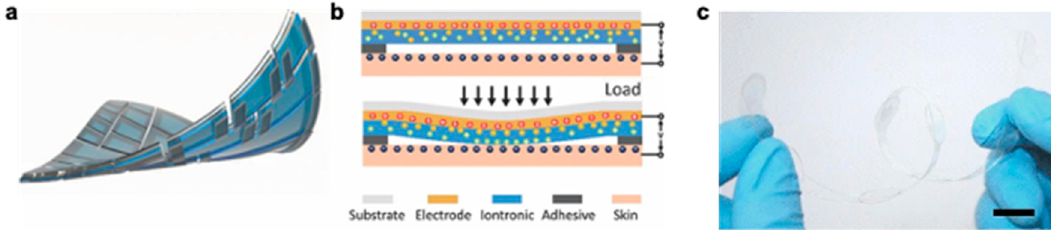
Figure 19. ( a ) Perspective view and ( b ) cross-sectional view of the epidermal-iontronic interface device. Reproduced with permission from [122]. Copyright 2018, John Wiley and Sons. ( c ) Photo of an iontronic pressure sensor array. Scale bar is 1 cm. Reproduced with permission from [125]. Copyright 2015, Springer